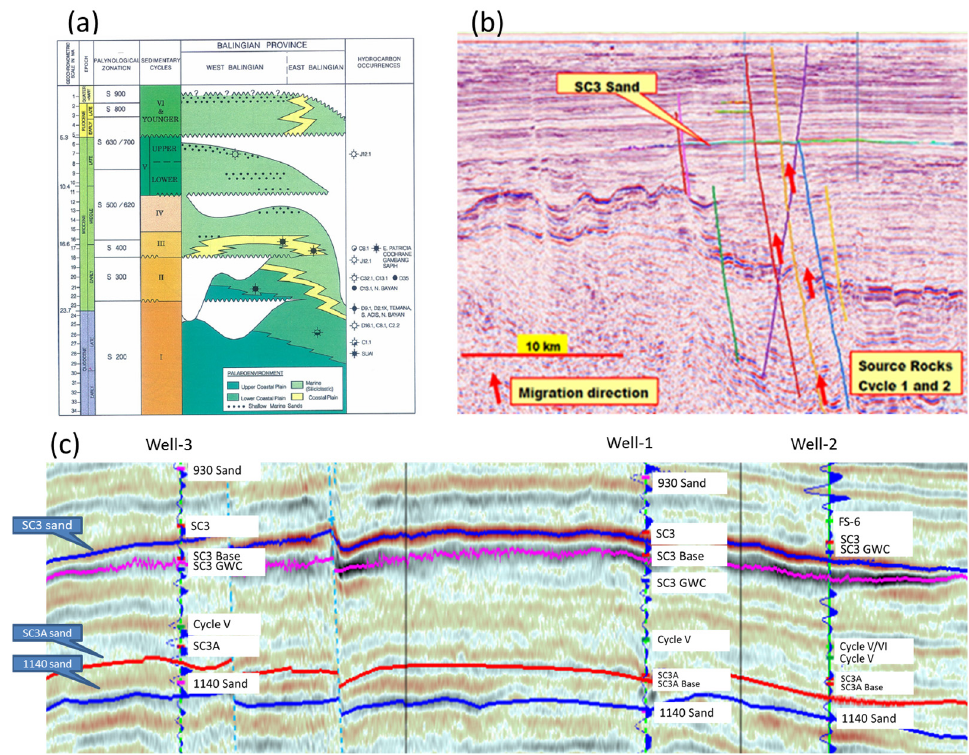
Figure 2 . Petroleum system and seismic data interpretation. ( a ) Generalized stratigraphy of the studied province showing the major hydrocarbon occurrences (Madon and Abolins 1999), ( b ) Regional E–W seismic section showing gas generation occurred from source rock at depth (Cycle 1 and 2) and migrated to the Field’s sands (SC3) by deep rooted faults. ( c ) NW–SE seismic section and seismic horizons interpretation of studied zone. Overlaid log is well site seismic trace (Courtesy Petronas Carigali).